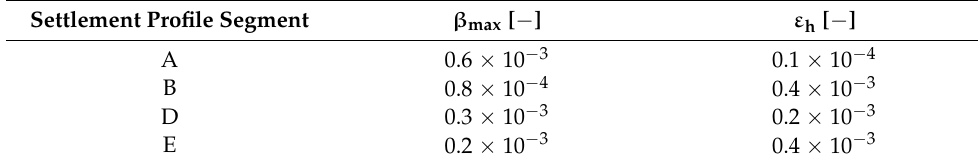
Table 3. Maximum angular distortion β max and horizontal strain ε h of the east − west directed walls. Settlement Profile Segment